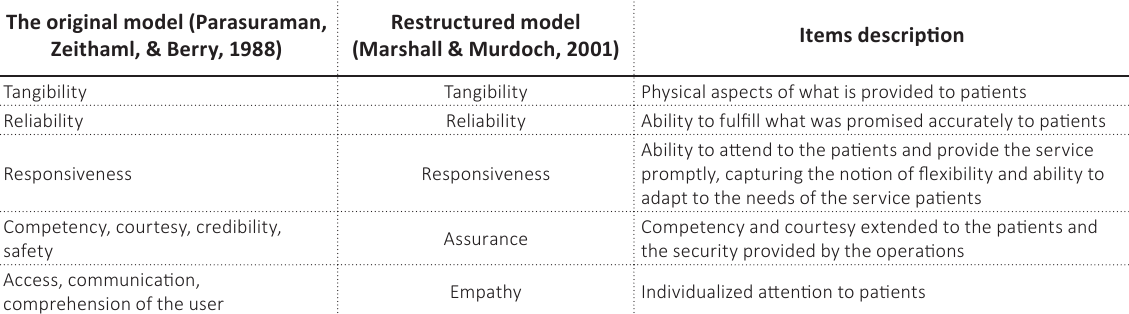
Source: Marshall and Murdoch